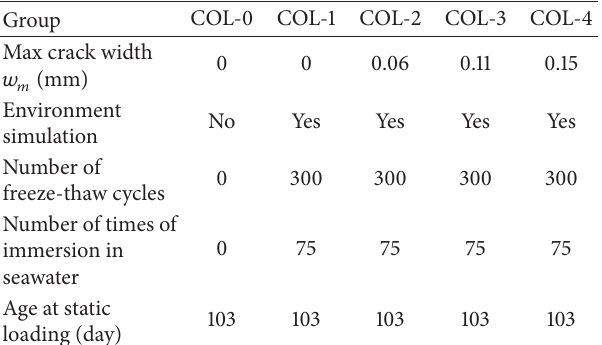
Figure 2: Sustained loading system to induce cracks. Table 2: Test conditions of reinforced concrete column